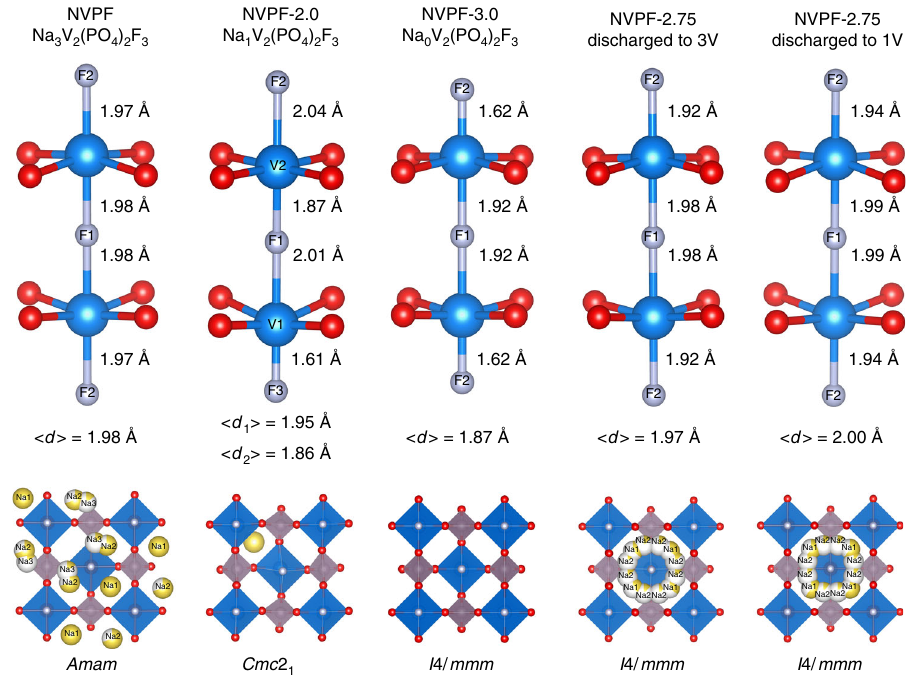
Fig. 5 V – F bond lengths and sodium distribution within the structure of NVPF samples. Structures of NVPF samples, from left to right: pristine, NVPF-2.0, NVPF-3.0, NVPF-2.75 discharged to 3.0 V, and NVPF-2.75 discharged to 1.0 V. Top: view of the VO 8 F 3 bioctahedra with relevant V – F bond lengths and the average V – O/F distances labeled as < d >; bottom: distribution of Na atoms within the structure. For each composition, the space group is indicated. V is blue, O is red, F is gray, Na is yellow, and Na vacancies are milky